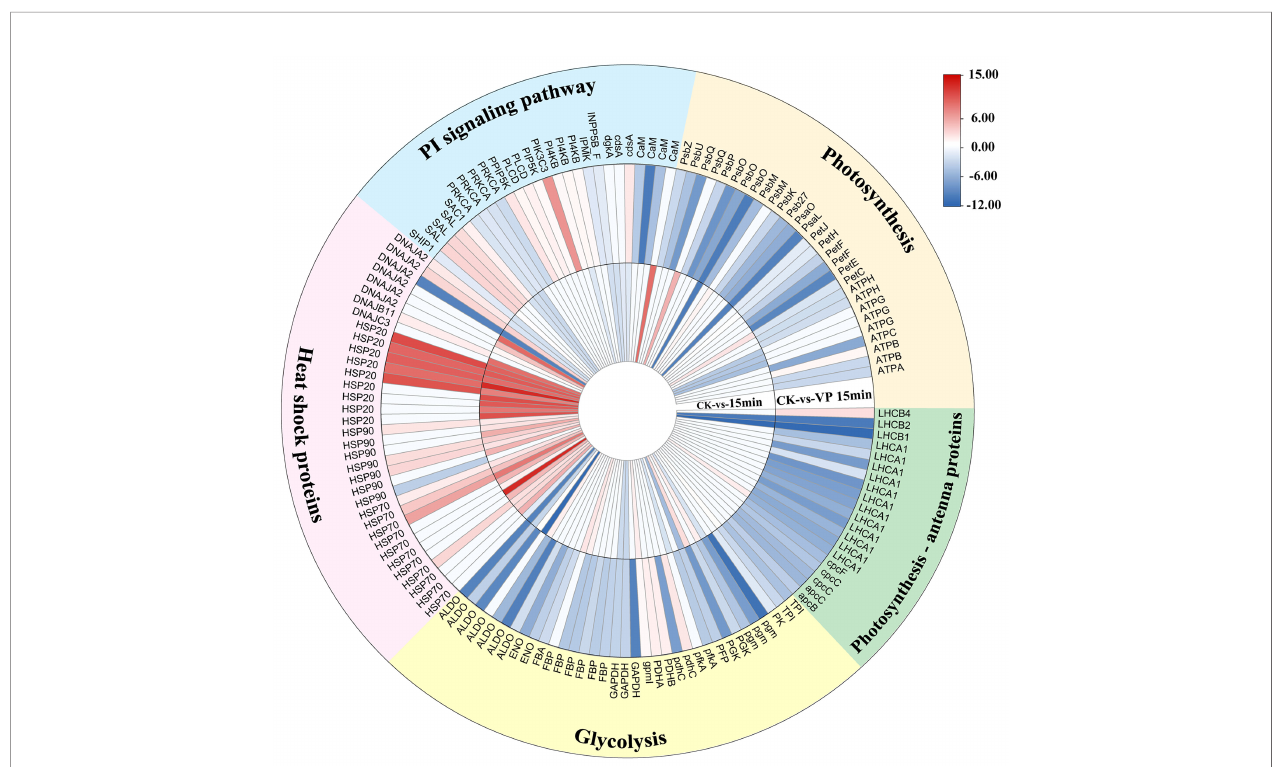
FIGURE 5 | Differentially expressed genes between untreated N. haitanensis thalli and thalli treated with verapamil under heat stress. CK, control (the thalli at normal condition); 15min, the thalli at 15 min heat treatment; VP15min, the thalli treated with verapamil at 15 min heat treatment. HSP, heat shock proteins; DNAJ*, DNAJ subfamily *; PI, phosphatidylinositol; CaM, Calmodulin; cdsA, Phosphatidate cytidylyltransferase; dgkA, diacylglycerol kinase; INPP5B_F, phosphatidylinositol- bisphosphatase; IPMK, inositol-hexakisphosphate kinase; PI4K, phosphodylinositol 4-kinase; PIK3C3; phosphoinositide 3-kinase; PI5K, phosphatidylinositol-4- phosphate 5-kinase; PLC, phospholipase C; PRKCA, Serine/threonine protein kinase; SAC1, phosphatidylinositide phosphatase; SAL, 3 ’ (2 ’ ),5 ’ -bisphosphate nucleotidase SAL1; SHIP1, inositol polyphosphate phosphatase; Psb*, Photosystem II* subunits; Psa*, photosystem I * subunit; PetC, cytochrome b6-f complex iron-sulfur subunit; petE, plastocyanin; petF, ferredoxin FNR; petH, ferredoxin – NADP + reductase; petJ, cytochrome c6; ATP*, ATP synthase * subunit; LHCA1, light- harvesting complex protein; LHCB*, chlorophyll a-b binding protein *; cpcC, phycobilisome linker polypeptide; cpcF, phycocyanobilin lyase beta subunit; apcB, phycoerythrin beta subunit; apcC, allophycocyanin subunit; TPI, triose phosphate isomerase; PK, pyruvate kinase; pgm, glucose phosphate mutase; PGK, glyceric acid phosphate kinase; PFP, pyrophosphate – fructose-6-phosphate 1-phosphotransferase; pfkA, 6-phosphofructokinase; pdhC, dihydrolipoamide acetyltransferase; PDH*, pyruvate dehydrogenase * subunit; gpmI, phosphoglycerate mutase; GAPDH, Glyceraldehyde-3-phosphate dehydrogenase; FBP, fructose 1,6- bisphosphatase place; ENO, enolase; FBA, Fructose-bisphosphate aldolase; ALDO, fructose diphosphate